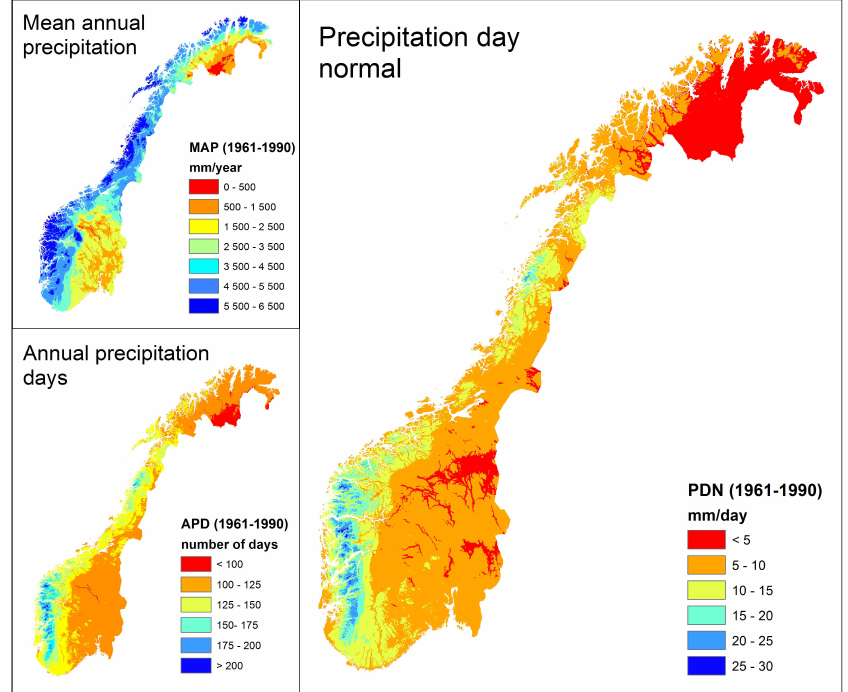
Fig. 1. Grids used for normalization of water supply data at debris flow locations: the precipitation day normal (PDN) is calculated by dividing the mean annual precipitation (MAP) by the average number of precipitation days per year (APD) and represents the typical amount of precipitation on a precipitation